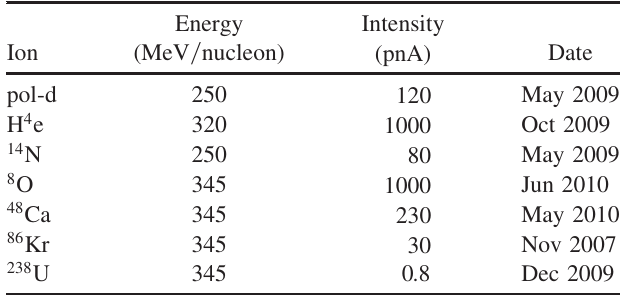
TABLE I. Beams accelerated at the RIBF accelerator complex with the maximum beam intensity achieved. The beam inten- sities are expressed in pnA ( 6 (cid:1) 10 9 particles = sec ).